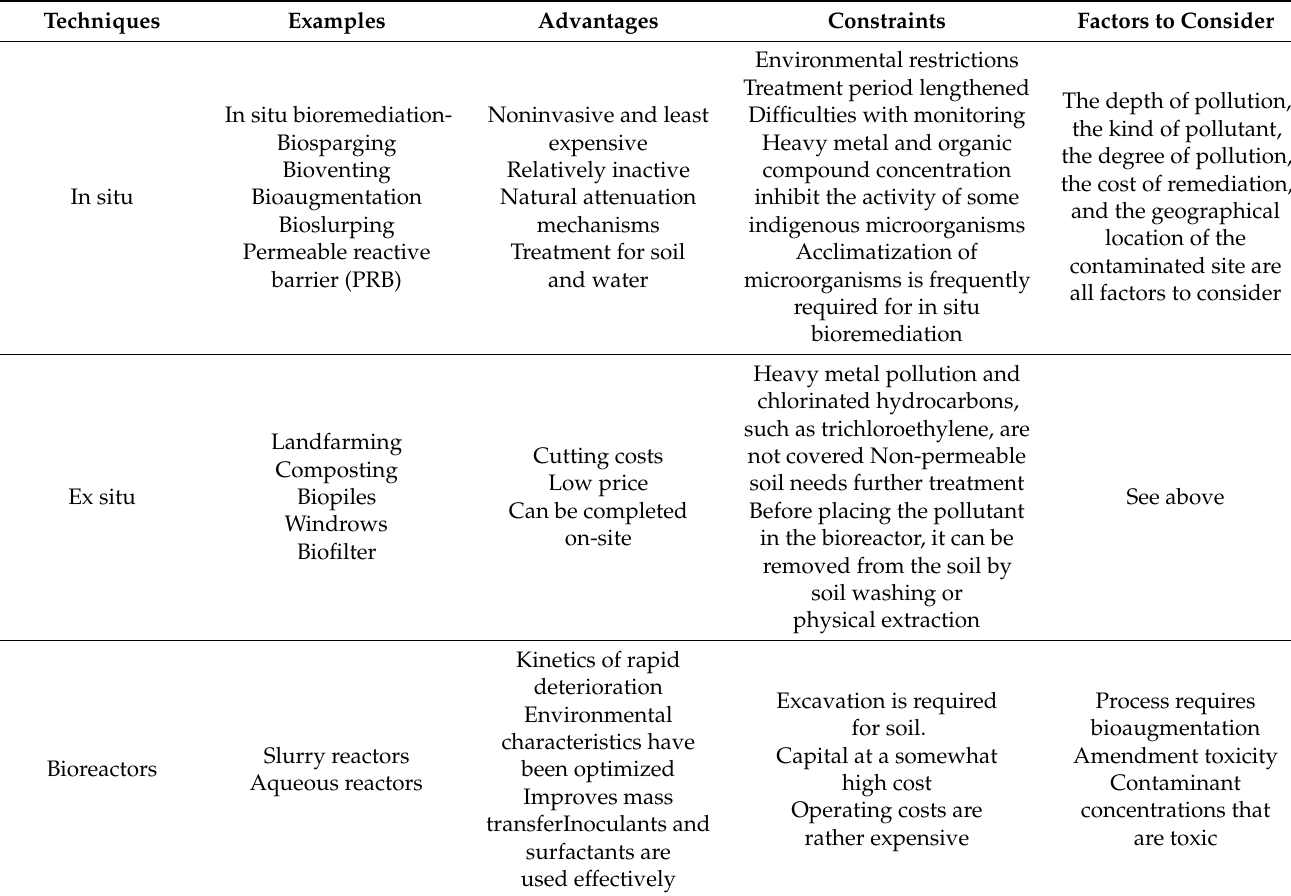
Table 2. Bioremediation methods, benefits, and limitations